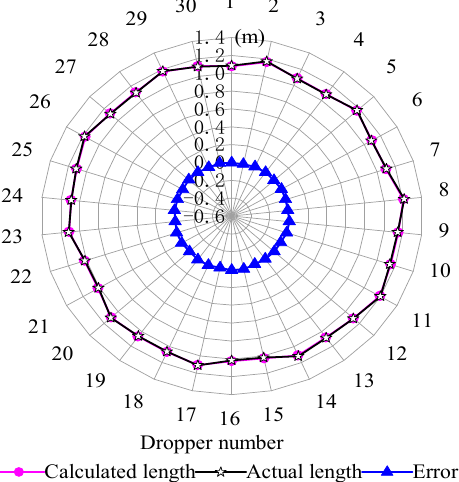
Figure 17. The partial results of the dropper length comparison.